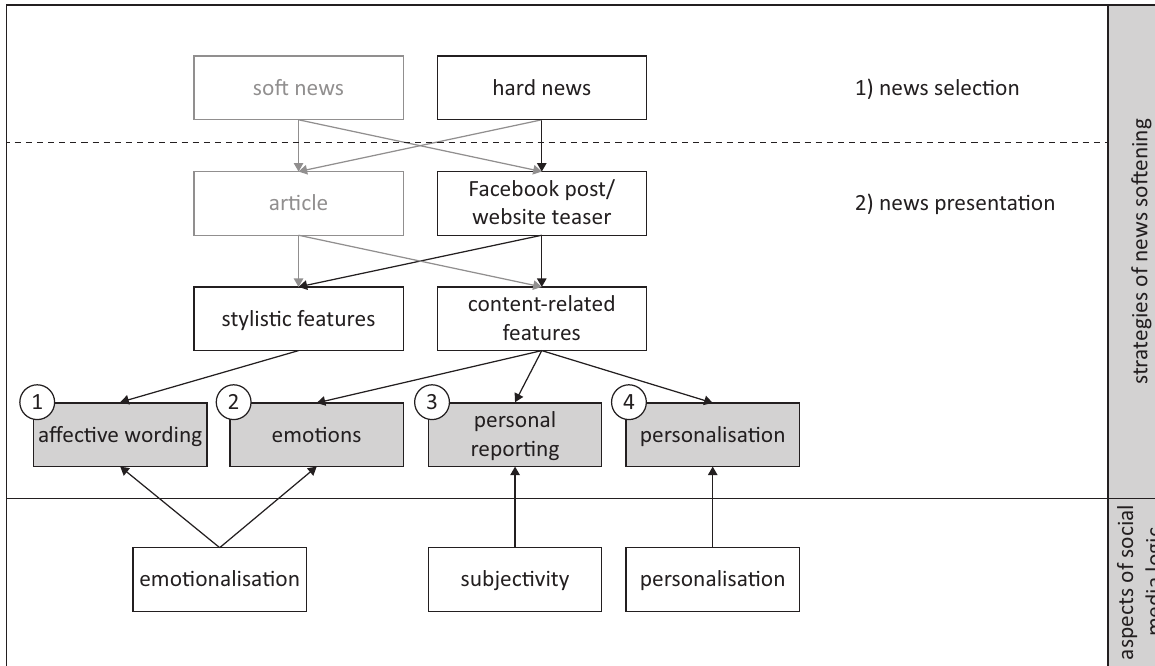
Figure 1. Journalistic news softening